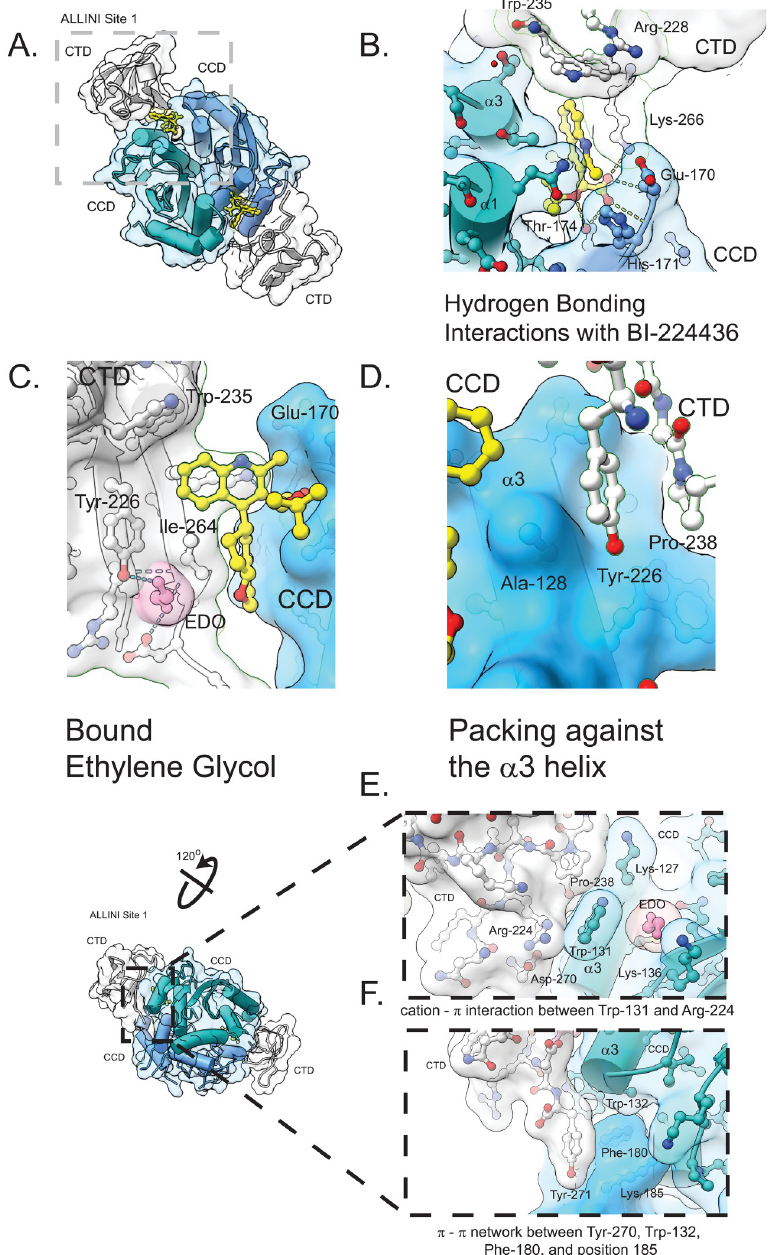
Fig 6. CTD interactions within the minimal ternary complex. A. Shown is the ternary complex, with CCD monomer chains colored in blue and cyan, BI-224436 in yellow, and the CTD colored in white. are Trp-235, Lys-266, and Ile-268 interactions with BI-224436 in ALLINI site 1. B. Hydrogen bonding interactions between Lys-266 from the CTD, the carboxylic acid moiety of BI-224436, and Glu-170, His-171, and Thr-174 from the CCD are highlighted. C. Shown is a bound molecule of ethylene glycol (EDO) within ALLINI binding site 1, created by the observed conformational change in Trp131, where bridging hydrogen bonds with Tyr-226 and Asp-270 are observed. D. Interactions between Tyr-226 and Ala-128, a common ex vivo resistance mutation site, on the α 3 helice is shown. E. A distal interdomain cation- π interaction network between Trp-131, Arg-224, and Asp 270 is shown. Bound behind the indole plane of the Trp-131 side chain is a well-ordered molecule of EDO, precluding further stabilizing cation- π interactions by Lys-127 and Lys-136. E. An aromatic π - π network between Tyr-271 and a cluster of aromatics at the C- terminal base of the α 3 helice in the CCD dimer is shown, including Trp-132, Phe-180, and Lys-185. In wild type HIV IN-1, position 185 is occupied by a